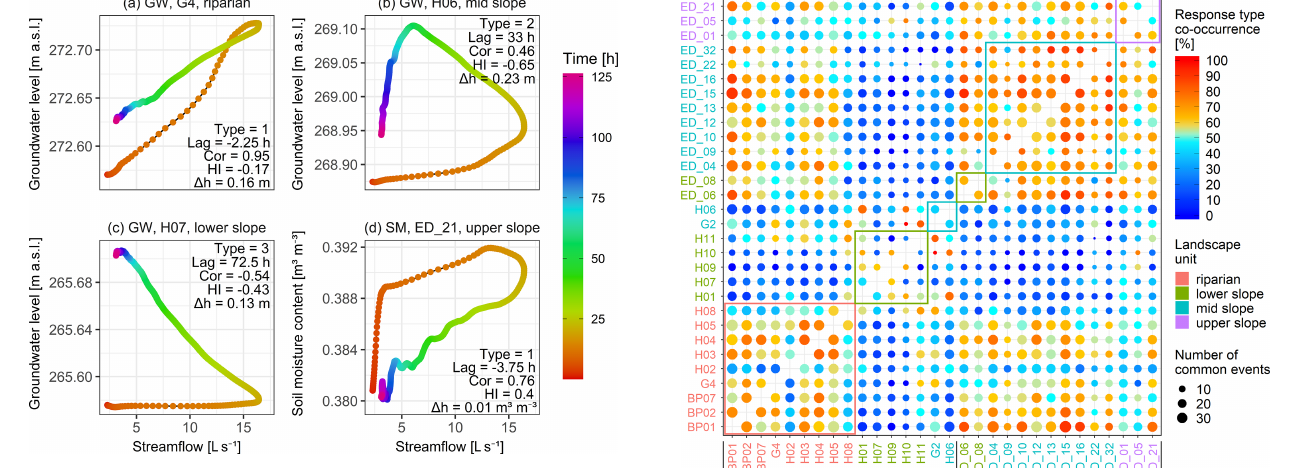
Figure 10. Hysteresis loops for event 29 (31 December 2017) (Fig. 3c). Each panel represents a different response type: (a) type- 1 groundwater (GW) response; (b) type-2 GW response; (c) type- 3 GW response; (d) type-1 soil moisture (SM) response. The points’ colour represents the time since the start of the event. Event dynam- ics of each station in relation to the streamflow is described by the response type (Type), peak-to-peak time (Lag), Spearman correla- tion coefficient (Cor), hysteresis index (HI) and groundwater table or soil moisture content change over the event ( (cid:49)h ).